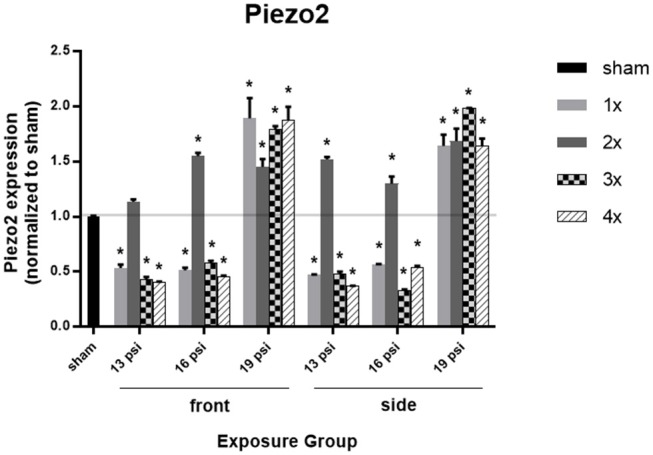
Quantification of Piezo2 expression measured by Western blot. Results presented as blast intensity for each orientation (front vs. side). Values normalized to sham. Statistical significance compared to sham: *p < 0.05 (Significance values in Supplemental Table 5). Data is expressed as mean ± SEM, normalized to sham. Representative Westerns shown in Supplemental Figure 2.